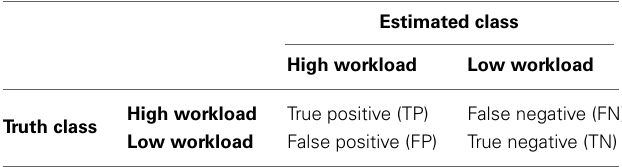
Table 1 | Classifier output structure (confusion matrix) used to determine d (cid:2)